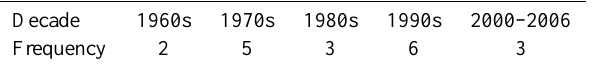
Table 2. Frequency (number of years per decade) of years with dou- ble nitrate peaks in each decade from 1960 to 2006 in the shallow ice